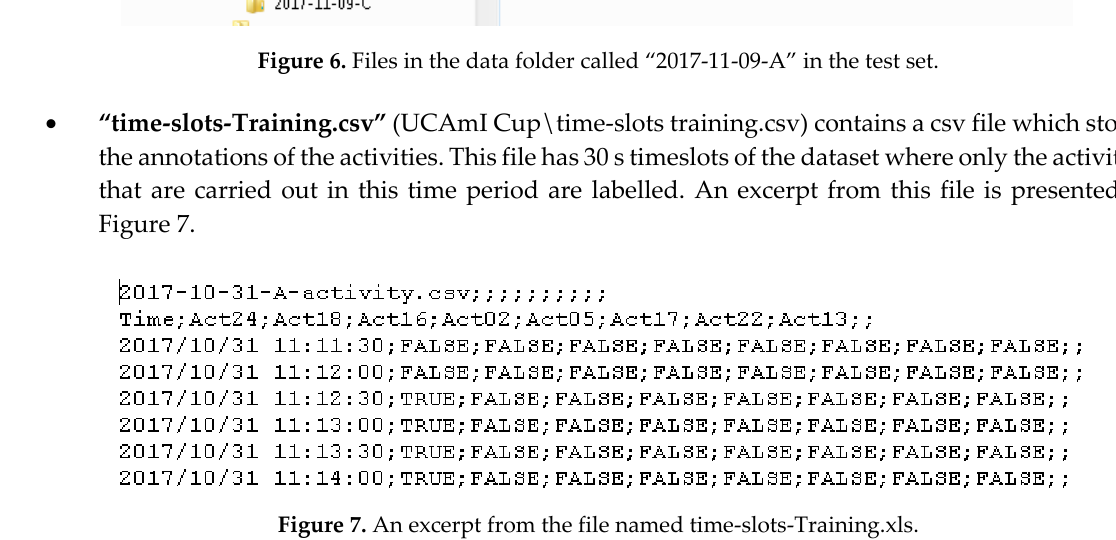
Figure 7. An excerpt from the file named